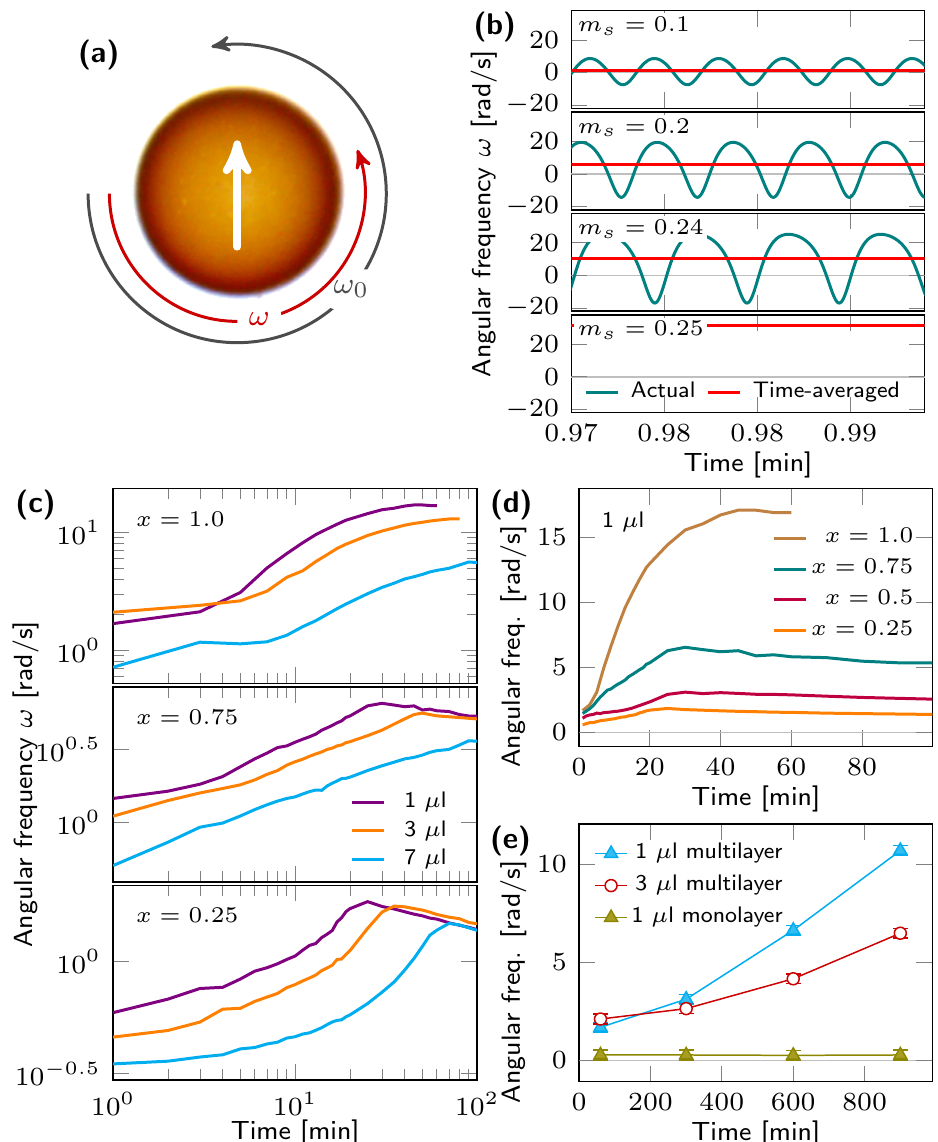
Figure 5. Magnetic field-driven gyration of ferromagnetic liquid droplets. ( a ) Droplet rotates with angular frequency ω to align magnetic moment along the external magnetic field, driven at ω 0 = 2 π × 5 Hz. ( b ) Modeling of 1 µ L droplet revealing friction-dominated desynchronized gyration for insufficient torque, and a reduction of the time-averaged experimental value due to periodically altering acceleration. ( c ) Experimental data for multilayer nanoparticle surfactants consisting of various (Fe 3 O 4 ) x :(SiO 2 ) 1 − x nanoparticle mixtures showing two different regimes where